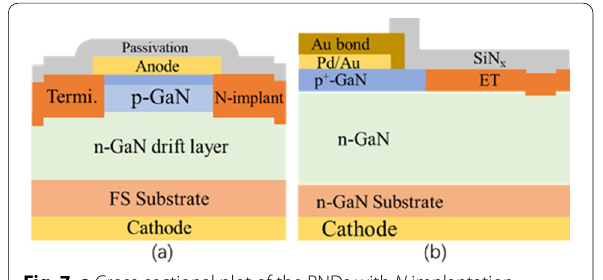
Fig. 7 a Cross‑sectional plot of the PNDs with N implantation termination, and b N implantation termination with fully and partially compensated [53, 84]